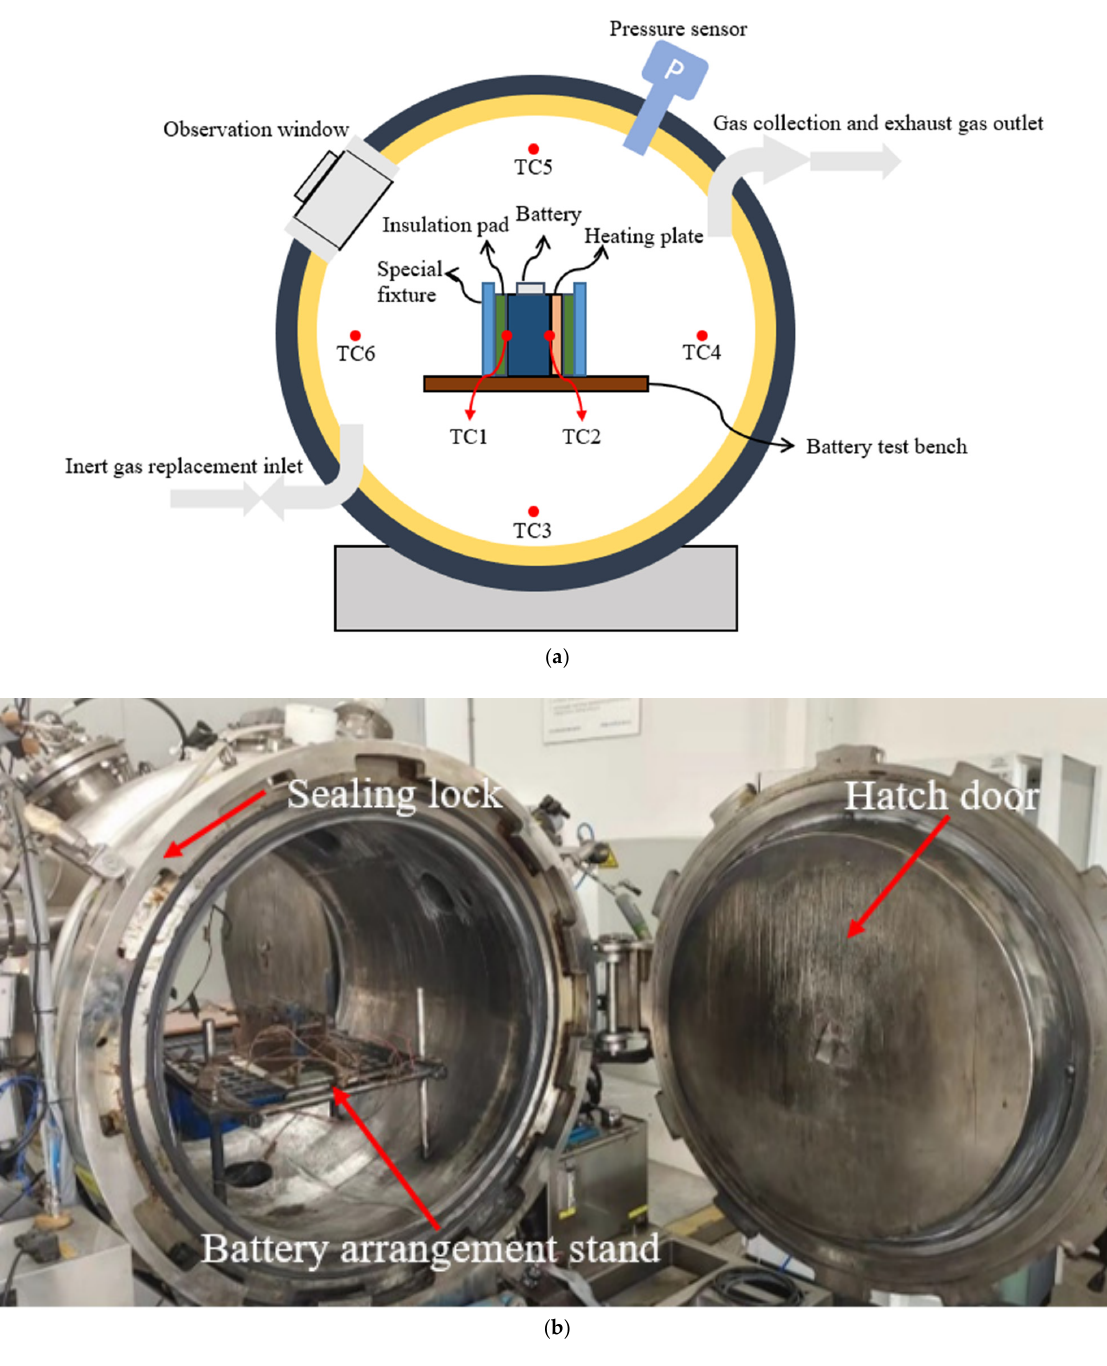
Figure 1. Pictures of experimental cabin . ( a ) Structure diagram of experimental cabin . ( b ) Physical picture of experimental cabin .